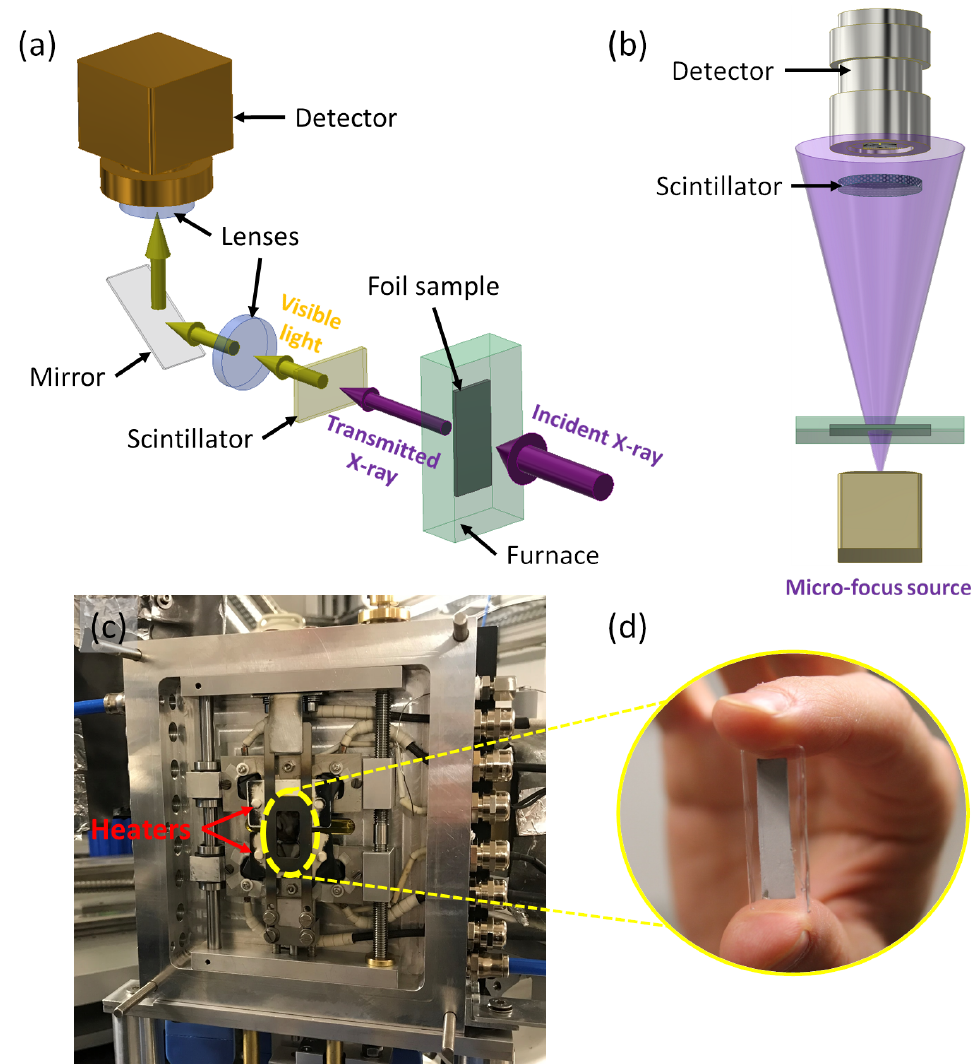
Figure 1. ( a ) Schematic of synchrotron X-ray radiography set-up for solidification experiments. ( b ) Schematic showing a typical set-up of laboratory-based X-ray radiography, where the foil sample is solidified horizontally (i.e., with gravity perpendicular to the sample surface). ( c ) The Bridgeman furnace for radiography experiments (with the front lid removed). ( d ) A foil radiography sample encapsulated in a quartz